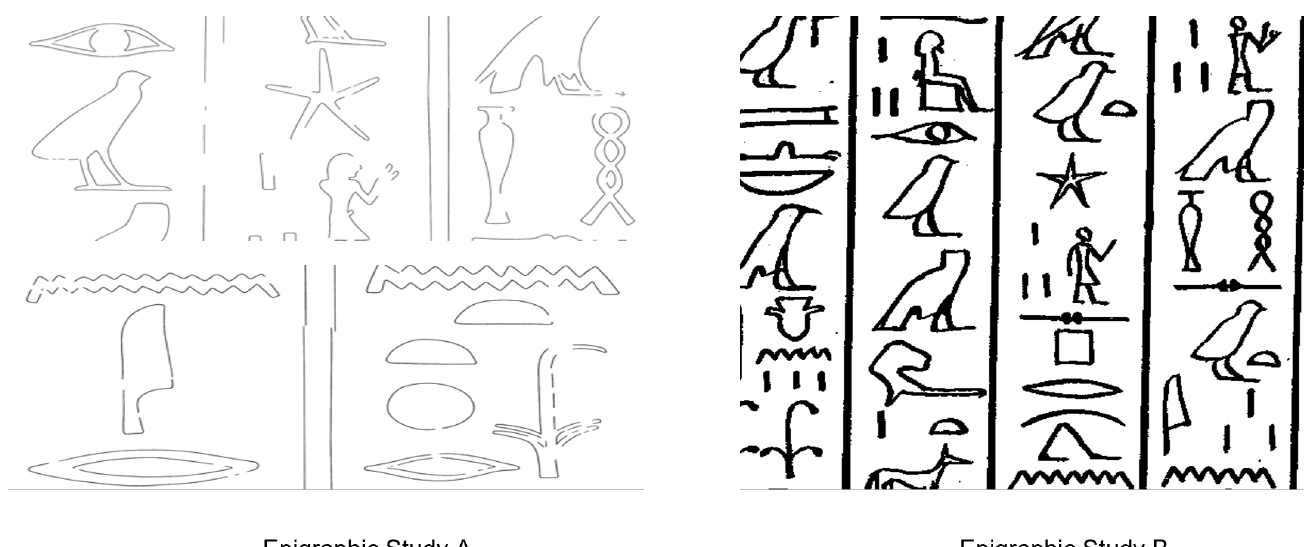
Figure 3. Samples of epigraphic studies used to develop and test the registration pipeline. Study